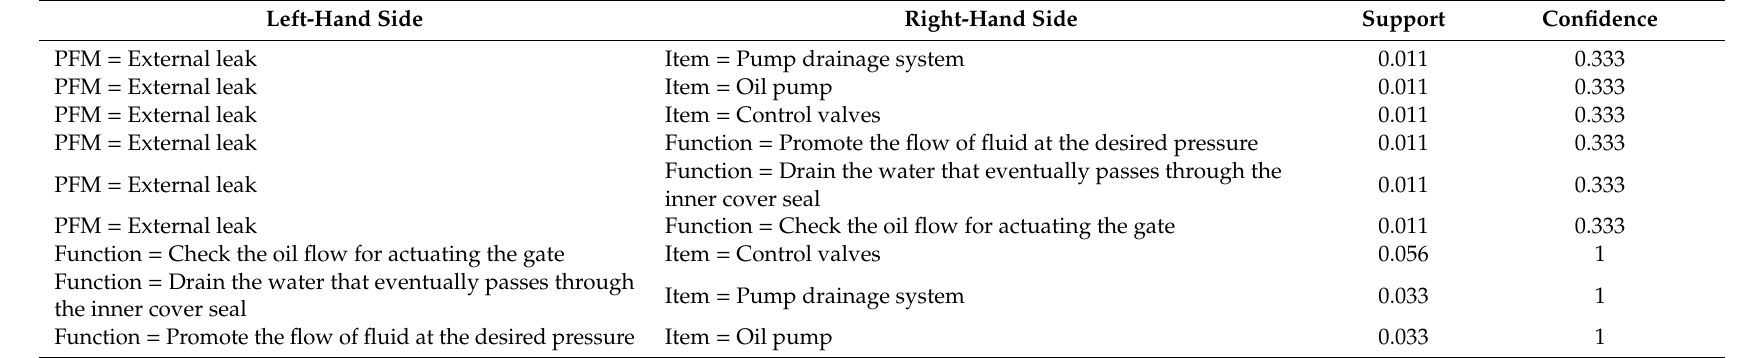
Table 2. Association Rules (ARs) among the PFM, item, and function of the network’s portion reported in Figure 2a.